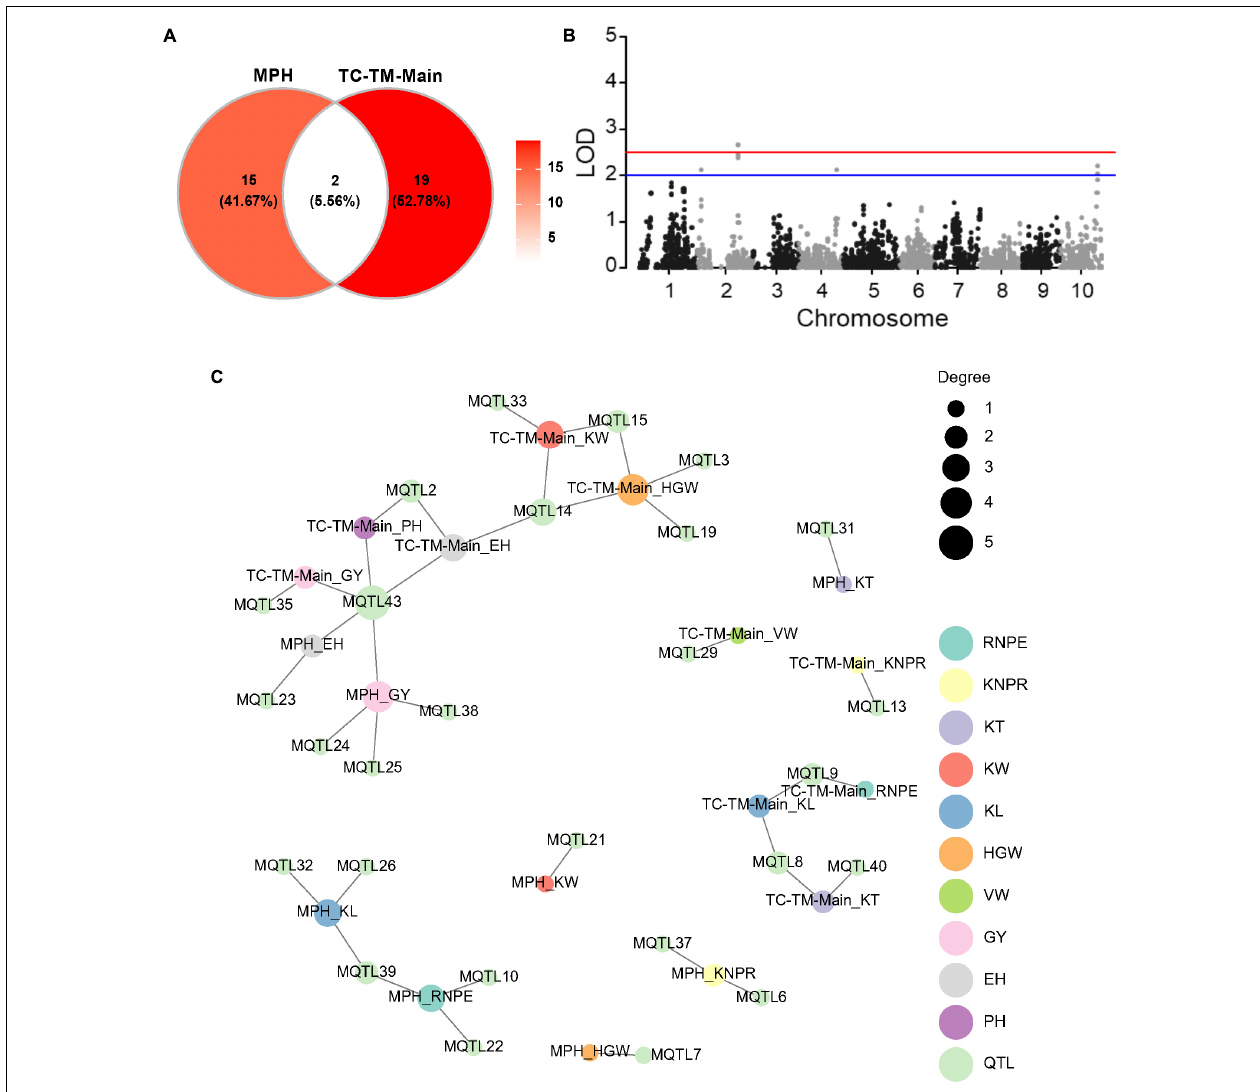
FIGURE 4 | Results of the main effect quantitative trait loci (QTL) mapping in the pooled Chang7-2 × RIL (TC)-Mo17 × RIL (TM) population and dominance effect QTL mapping for midparent heterosis (MPH). (A) Venn diagram showing the numbers of pleiotropic QTL overlapping between TC-TM-Main and MPH. TC-TM-Main is the mapping results for the additive and dominance effects of QTL from the pooled population of TC and TM. MPH represents the result of dominance QTL mapping for midparent heterosis. (B) Dominance QTL identified for kernel number per row in the pooled TC-TM population. (C) Trait-QTL network for 10 traits and QTL identified in the TC-TM-Main and MPH datasets. The connections between traits and QTL are linked if a QTL was identified for this trait. PH, plant height; EH, ear height; RNPE, row number per ear; KNPR, kernel number per row; KT, kernel thickness; KW, kernel width; KL, kernel length; VW, volume weight; HGW, hundred grain weight; GY, grain yield per plant; LOD, log of